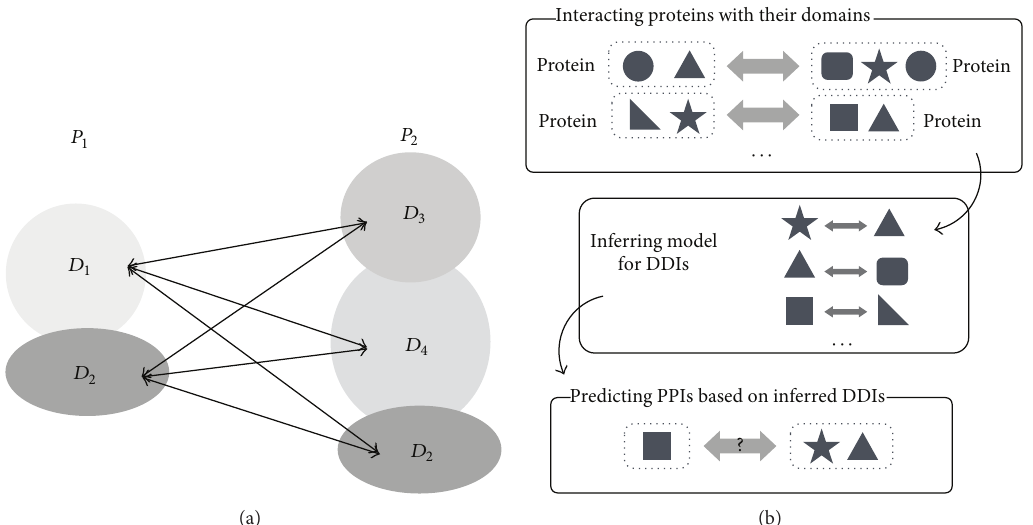
Figure 1: (a) Illustration of protein-protein interactions (PPIs) model based on domain-domain interactions (DDIs). (b) Schematic overview of PPIs prediction based on